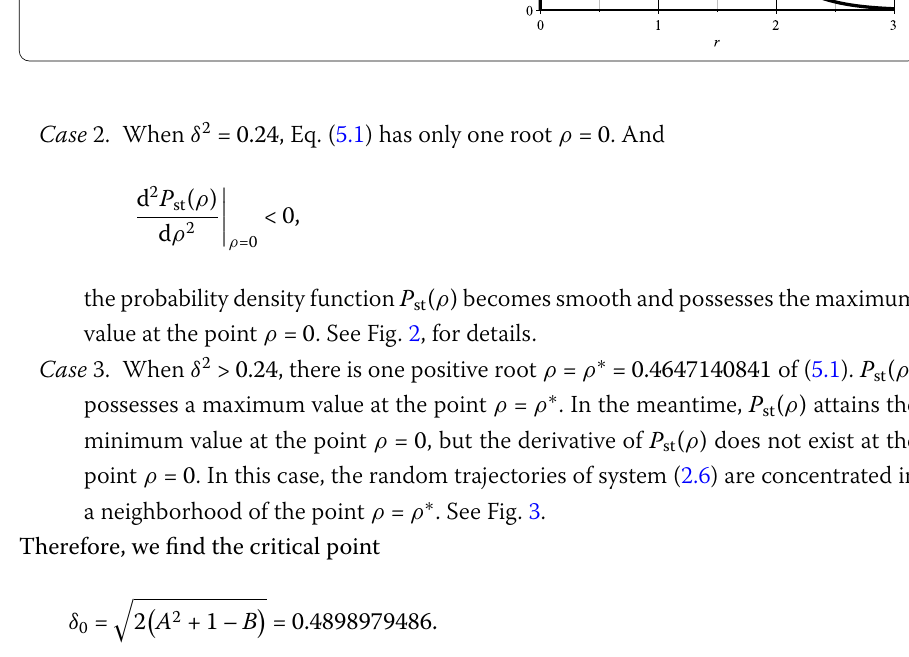
Figure 3 Portraits of P st ( ρ ) when A = 1, B = 1.88, δ = 0.5898979486 > 0.4898979486 = δ